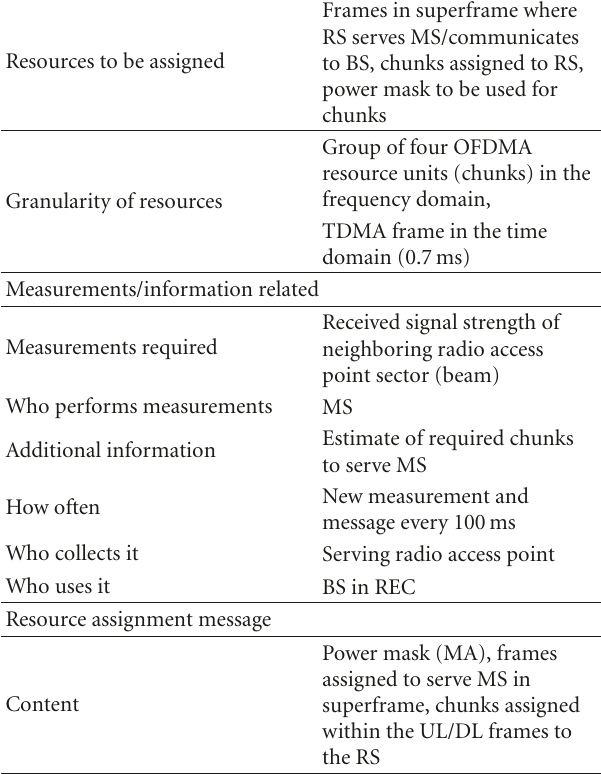
Table 2: Example of essential elements of resource assignment